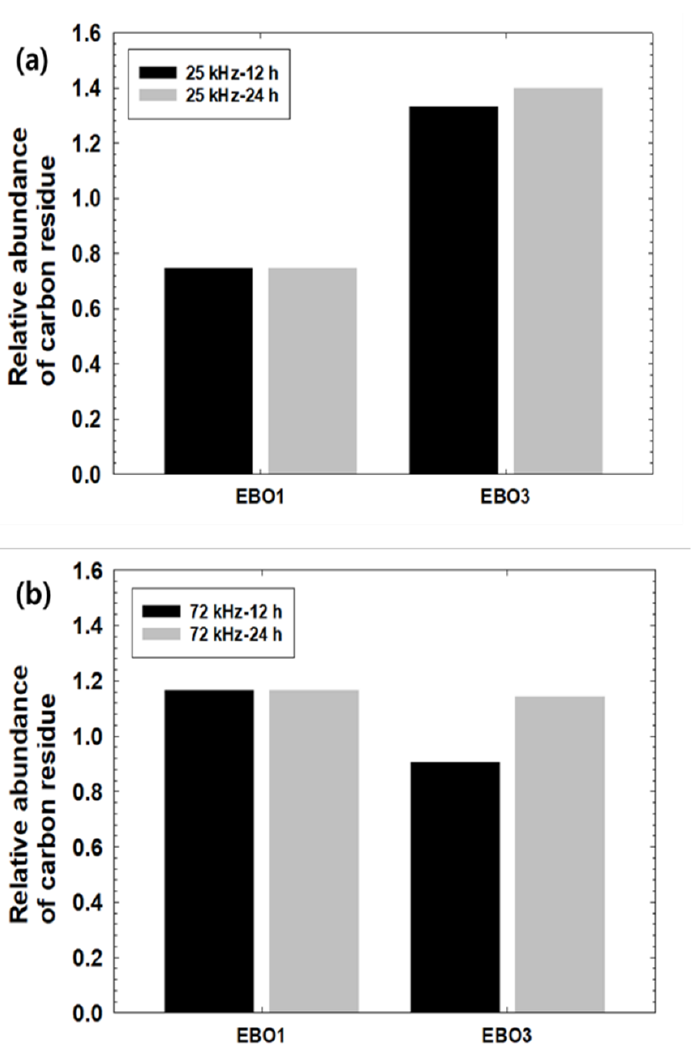
Figure 3. Variations in carbon residue for EBO1 and EBO3 after irradiation times of 12 h and 24 h at frequencies of ( a ) 25 kHz and ( b ) 72 kHz.